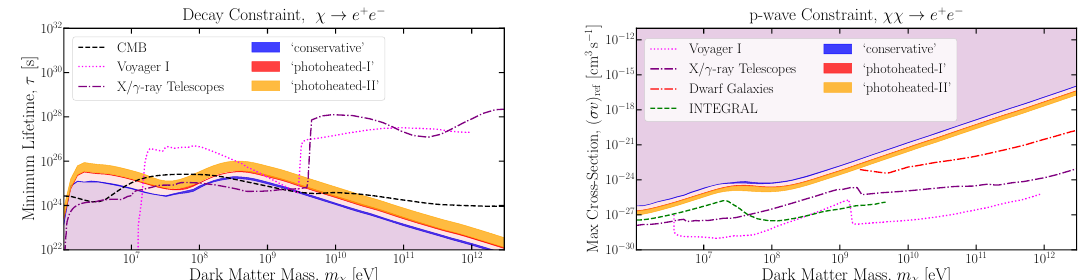
Figure 13: Selected bounds on the DM decay lifetime ( left panel ) and annihilation cross section ( right panel ) for annihilation / decay to e + e − . The blue and red lines and orange bands represent constraints derived from the Lyman- α forest under var- ious assumptions for the astrophysical background; the black dashed line indicates the CMB bound (driven primarily by excess early ionization); the pink dotted line indicates limits on low-energy cosmic rays from Voyager I; green-dashed and purple dot-dashed lines indicate limits from X-ray and gamma-ray telescopes. Reproduced from Ref. [ 71 ] ; see that work for further